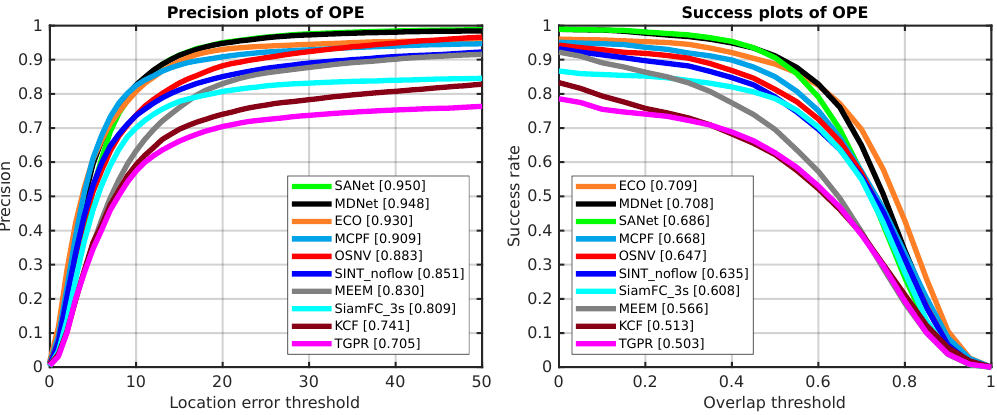
Figure 4. The OPE results of 10 tracking algorithms on OTB-2013. The left side is precision plots and the right side is success plots, which are both evaluated on OTB-2013.